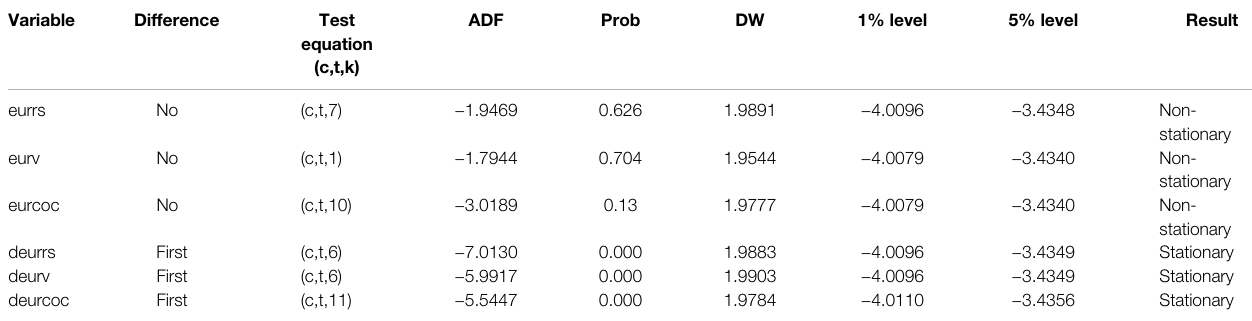
TABLE 2 | Result of the ADF test for US dollar/Euro.